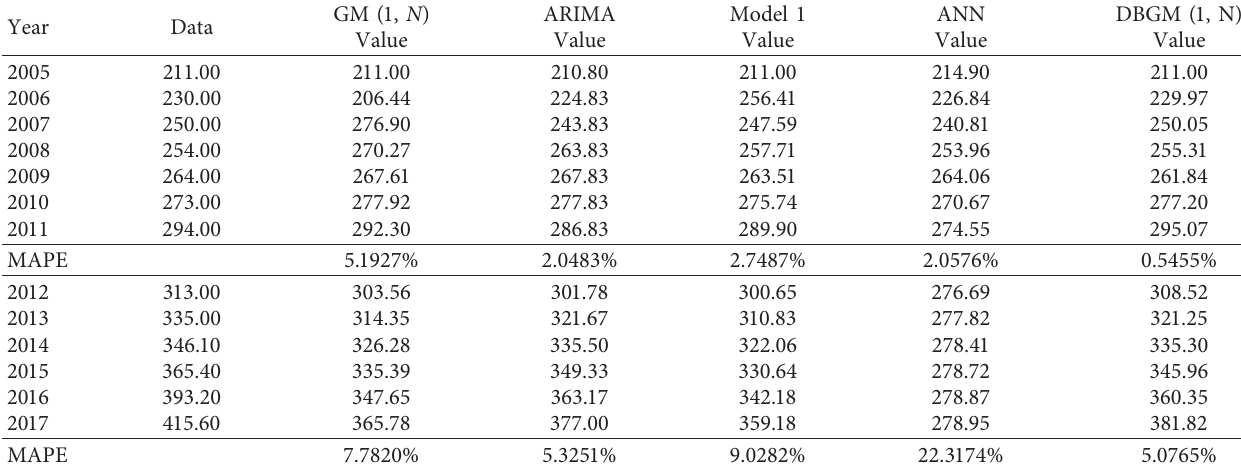
Table 6: The predicted values and APEs of Model 1, DBGM (1, N ) model, and DBGM (1, N ) model in Case 3.